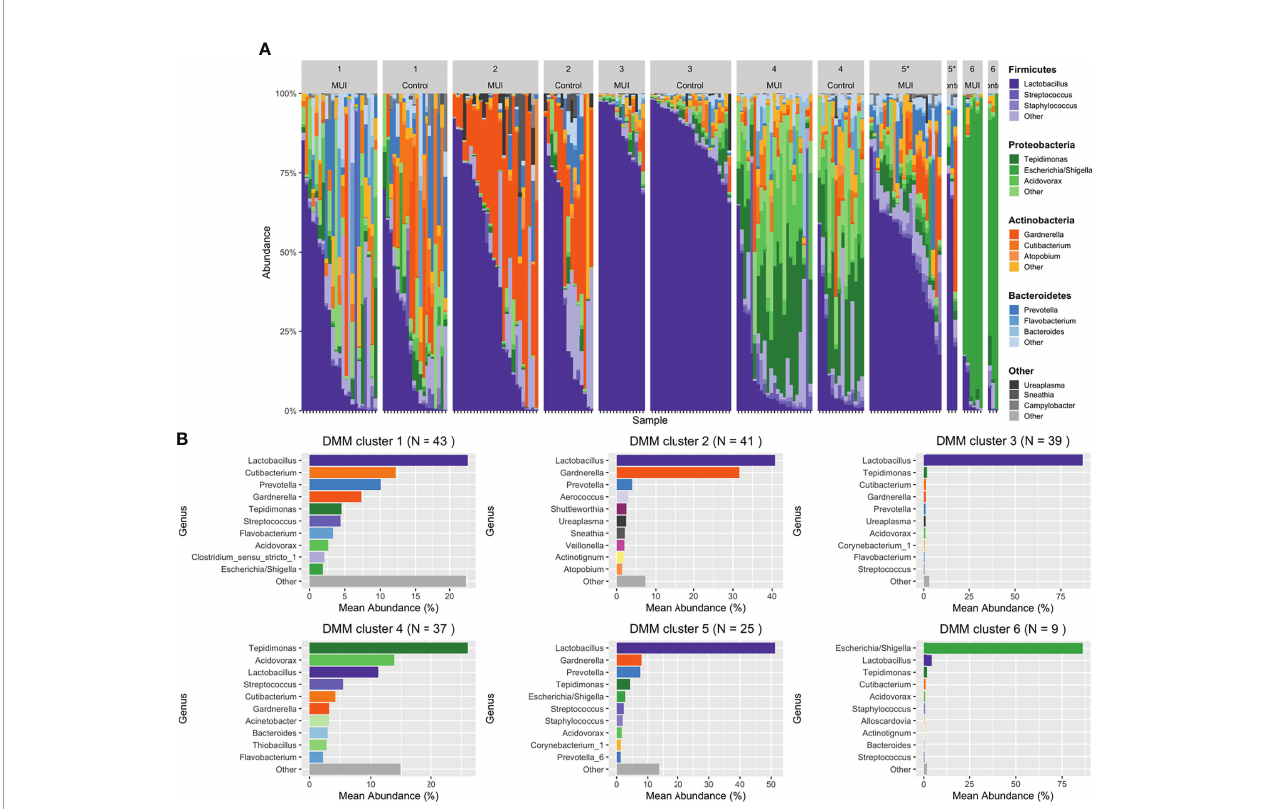
FIGURE 7 | Stacked bar plots illustrating results from updated analysis when combining fi ltered ASVs from individual samples into bacterial communities using DMM clustering. For DMM clustering a total of 6 clusters were chosen a priori . Clusters are numbered with each cluster further organized by those samples originating from women with MUI versus control. (A) shows DMM clustering results with cluster membership that is signi fi cantly different between MUI and controls identi fi ed with an asterisk(*). (B) shows more detail about the relative abundances of various genera that contribute to each